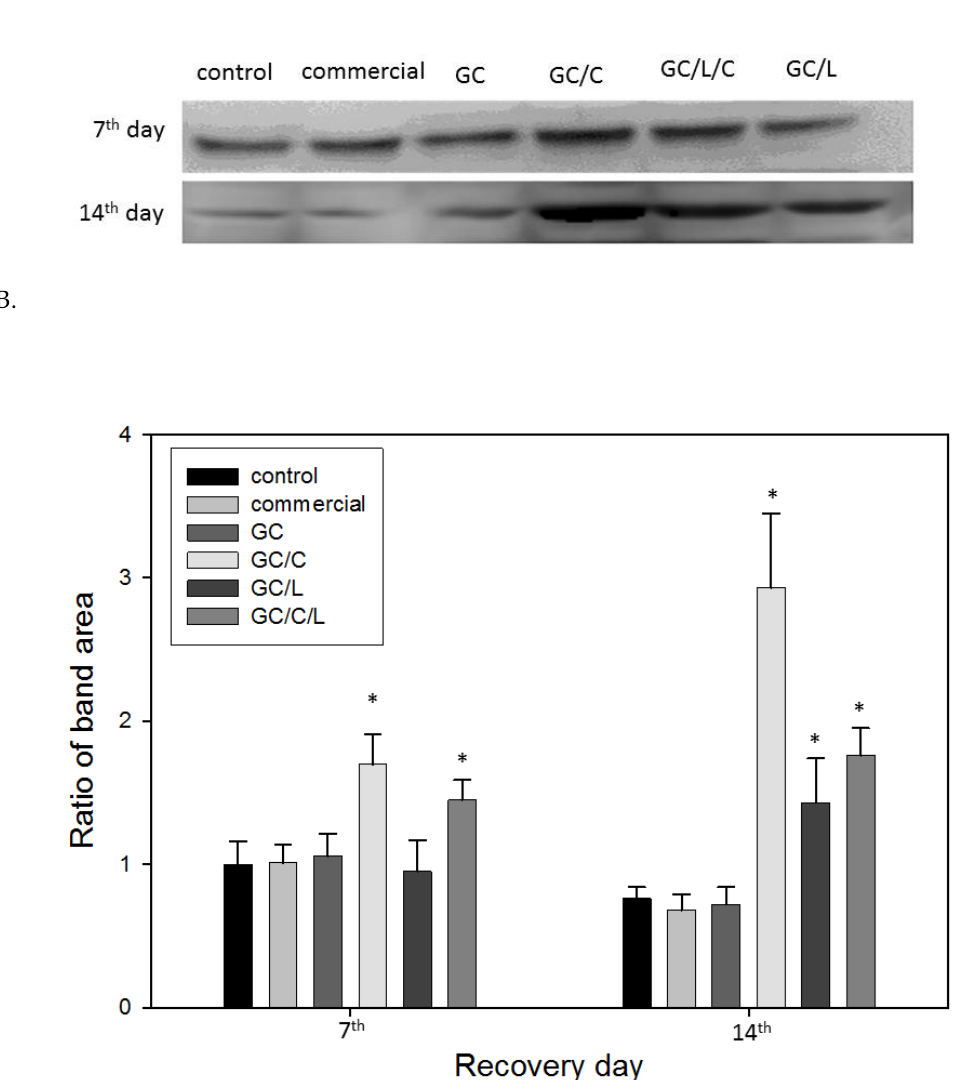
Figure 9. ( A ) Western blot analysis of TGF- β protein in wounds treated with a GC, GC / L, GC / C, and GC / L / C sca ff olds, commercial (Comfeel ® ), or gauze (control) at seventh and 14th day. ( B ) TGF- β protein band-ratio in wounds treated with various membranes on the 7th and 14th day.